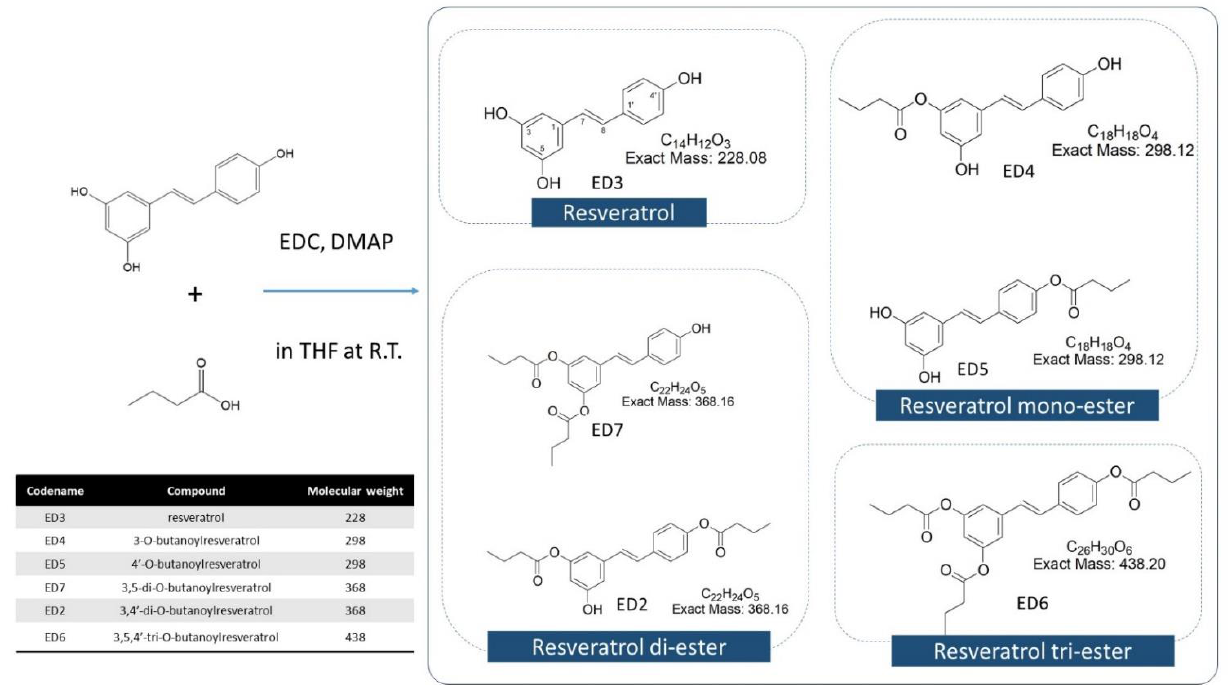
Figure 1. Structures in the resveratrol butyrate ester (RBE) mixture after separation and purification.